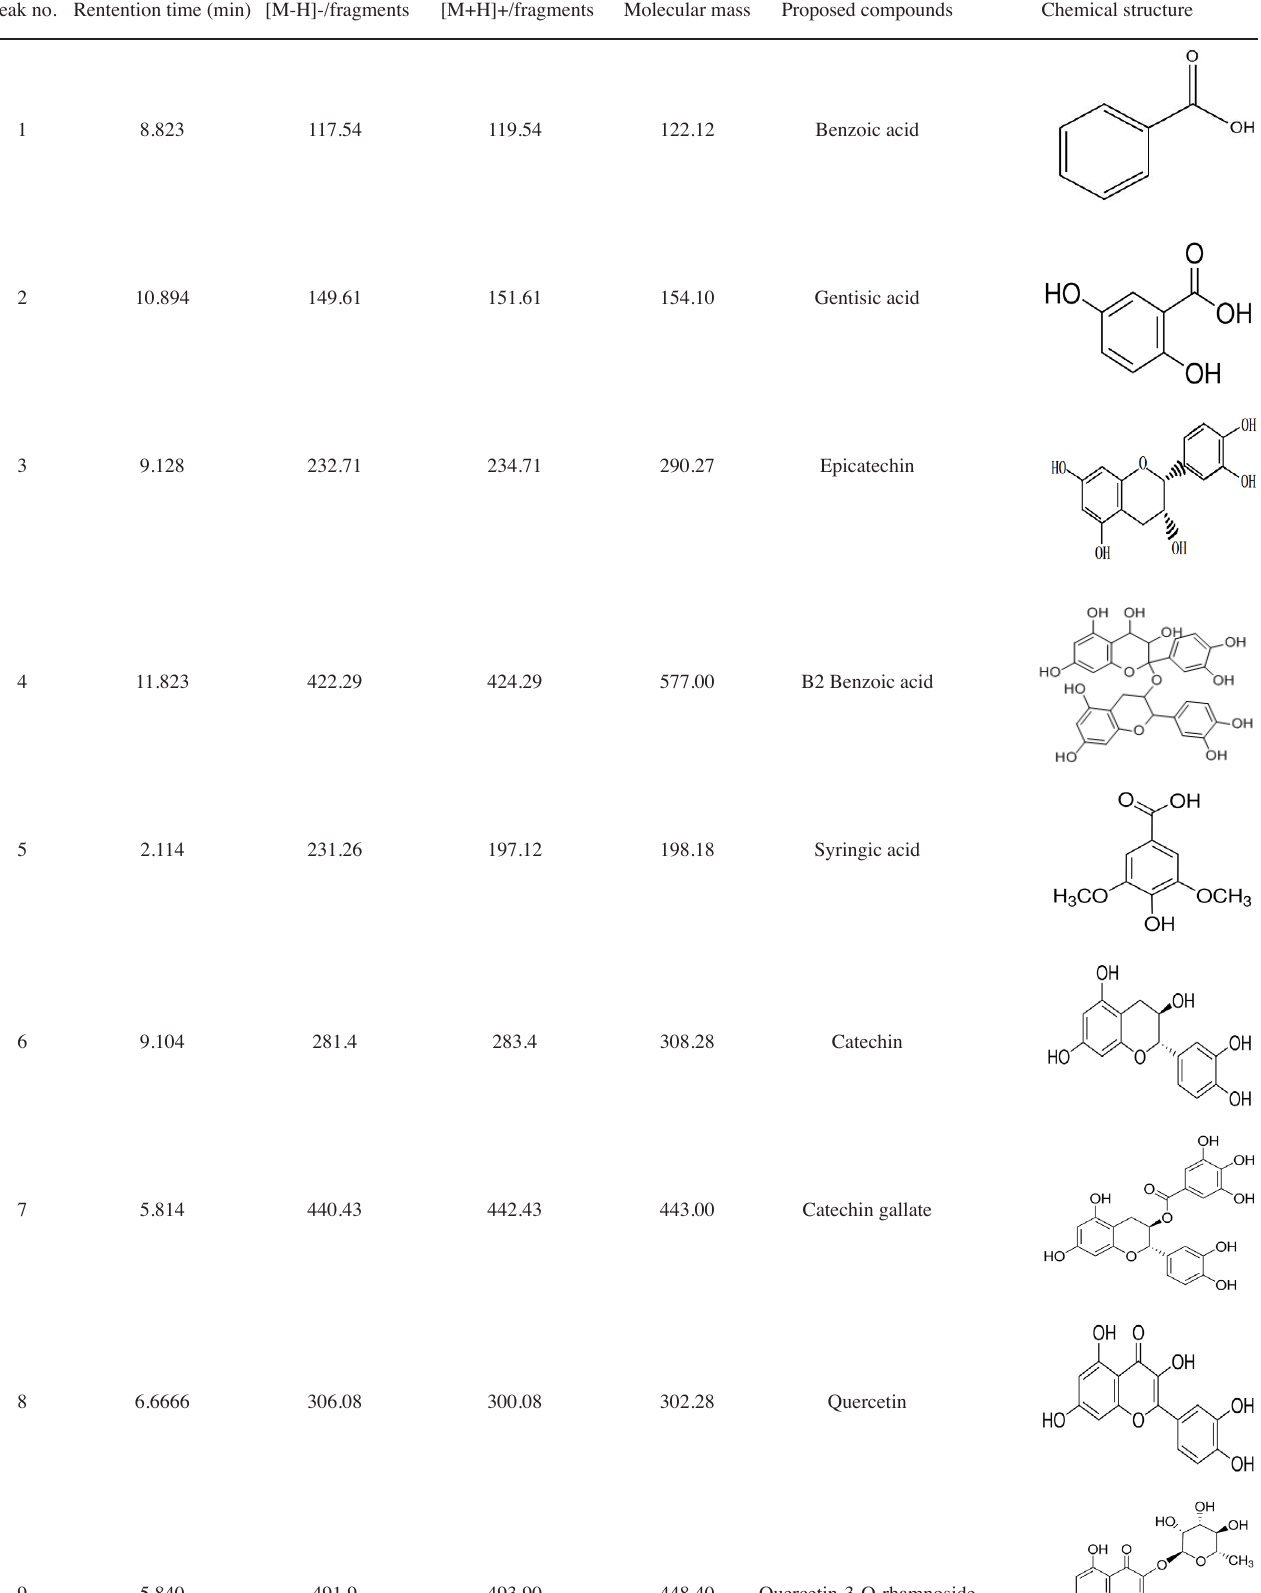
Tab. 6: Analysis of polyphenols in maize filaments by HPLC-MS/MS method. Peak no. Rentention time (min)